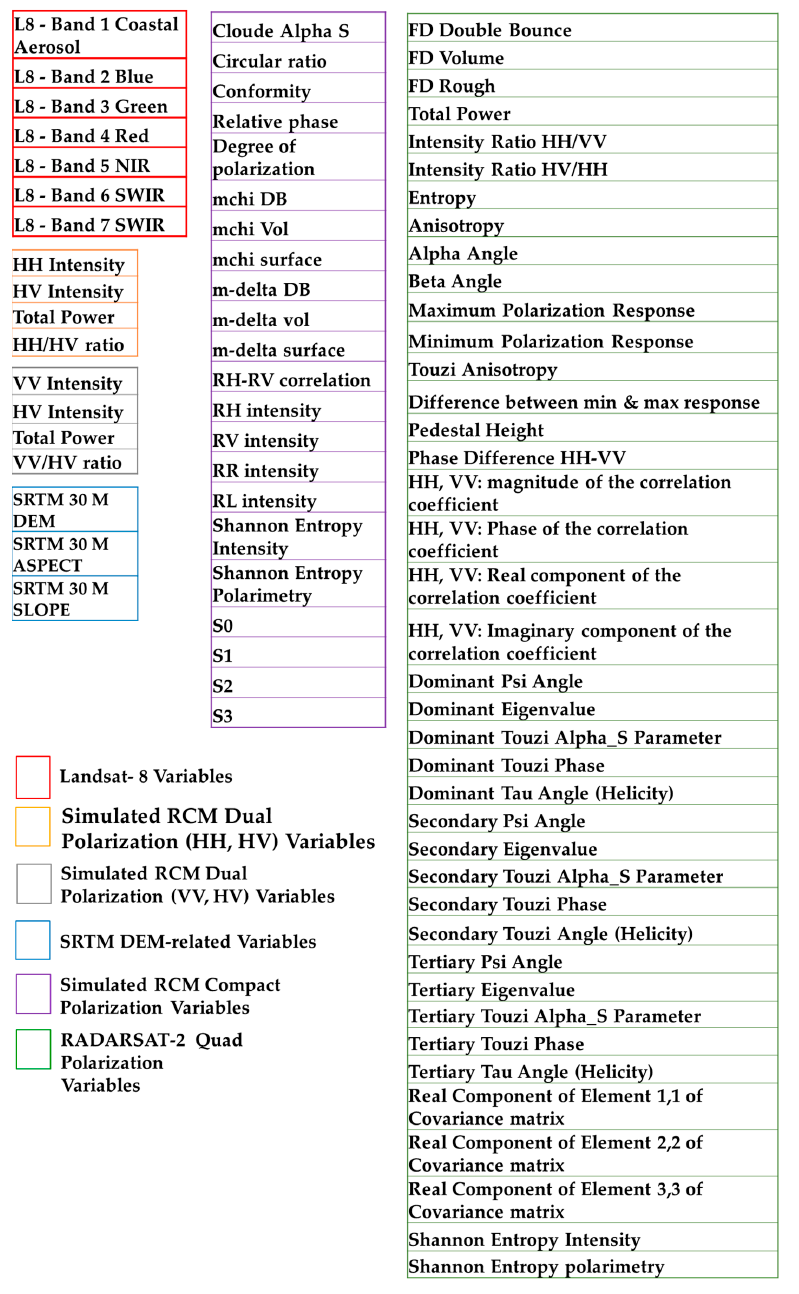
Figure 2. Predictor variables that were included in the Random Forest (RF) models.